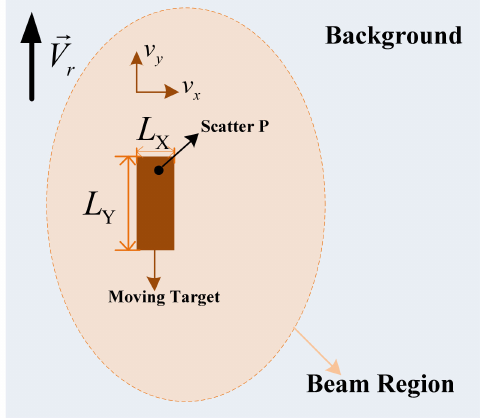
Figure 12. Beam illumination and moving target